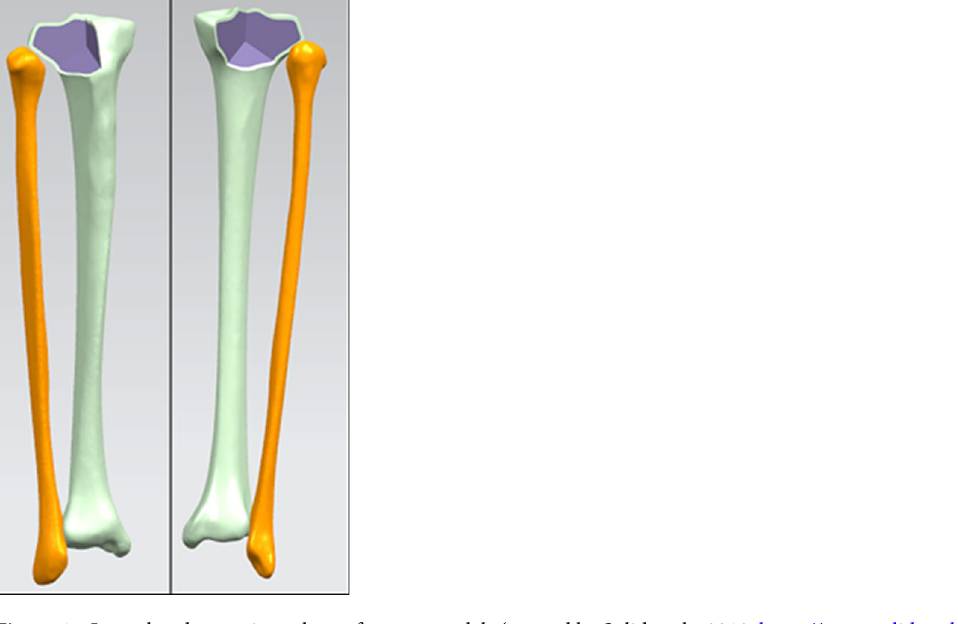
Figure 1. Lateral and posterior column fracture models (created by Solidworks 2018, https ://www.solid works